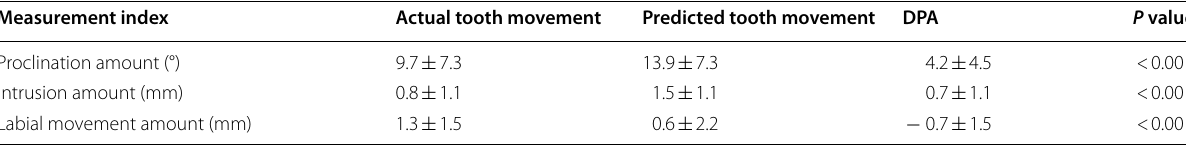
* P < 0.05 indicated statistical